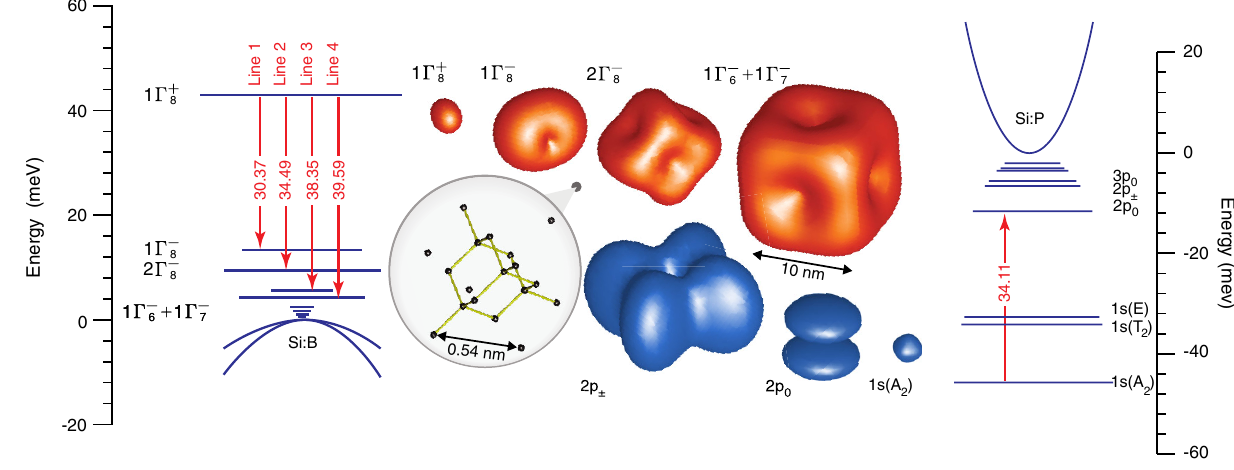
FIG. 1. Schematic of the energy levels and optical transitions in Si:B shallow acceptors. The acceptors Si:Al and Si:Ga have similar spectra with different chemical shifts for the ground state (the absorption spectra for these three species are shown in Fig. 7 below). The group. The envelope functions for the lowest four states are shown (the surfaces are states are labeled with their symmetry from the T d constant probability density surfaces that enclose 50% of the normalization). Each state is oriented relative to the cubic-crystal axes (indicated by the crystal-structure inset, which also illustrates the huge scale of the envelope functions relative to the lattice constant), and all are multiply degenerate. For each energy level, one of the cubic harmonics is shown. For comparison, the Si:P shallow donor wave functions are shown on the same scale; the dimensions are shown in nm. The picture shows that the boron excited-state wave functions are somewhat larger than the excited phosphorus